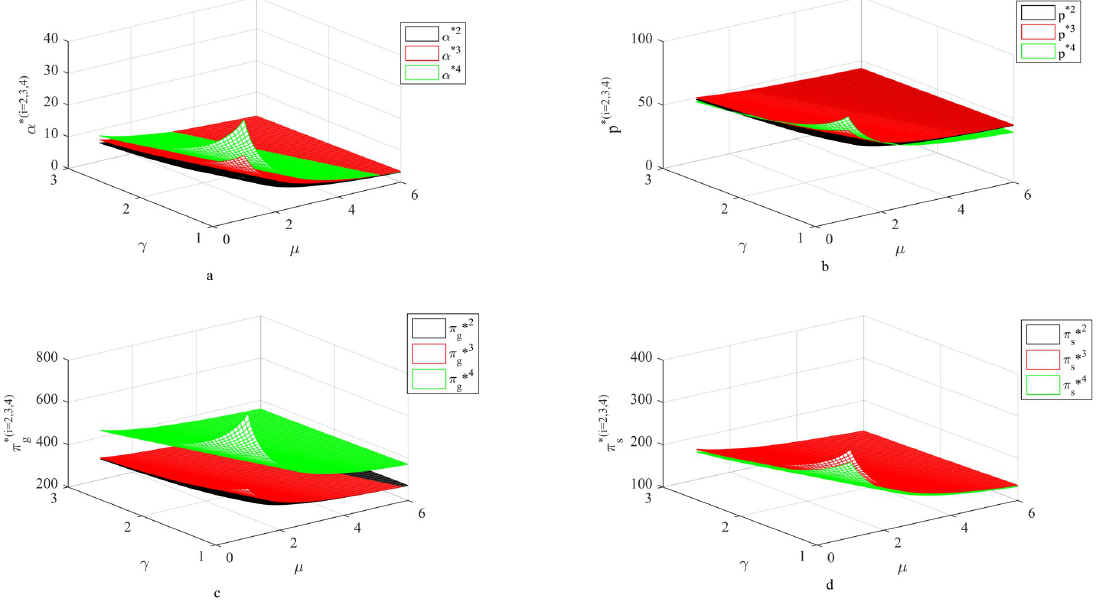
Fig 3. Influence of μ , γ on fresh-keeping decisions and